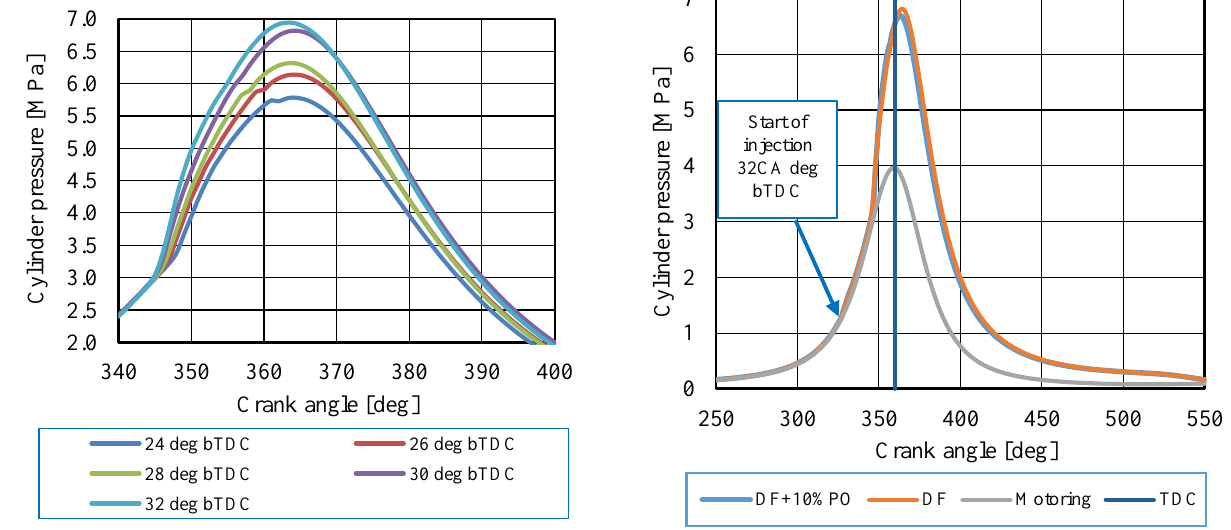
Fig. 5. Cylinder pressure vs. crank angle range 340–400 deg for a variable start of fuel injection, fuel: DF